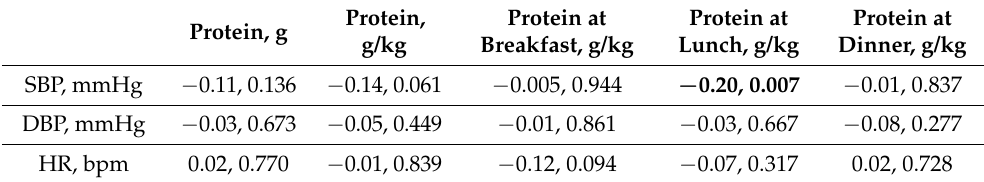
Table 2. Unadjusted Pearson’s correlation (n =